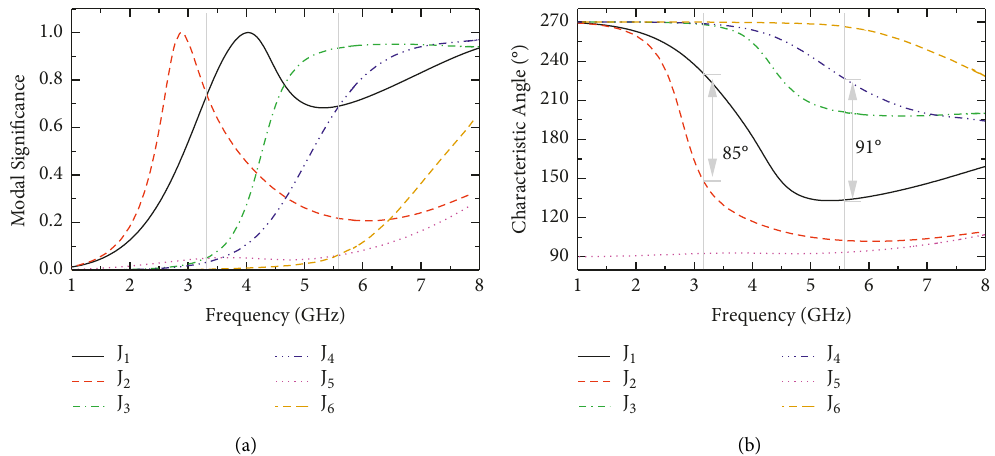
Figure 3: (a) Modal significance and (b) characteristic angle for the first six modes of radiator calculated at 4GHz.